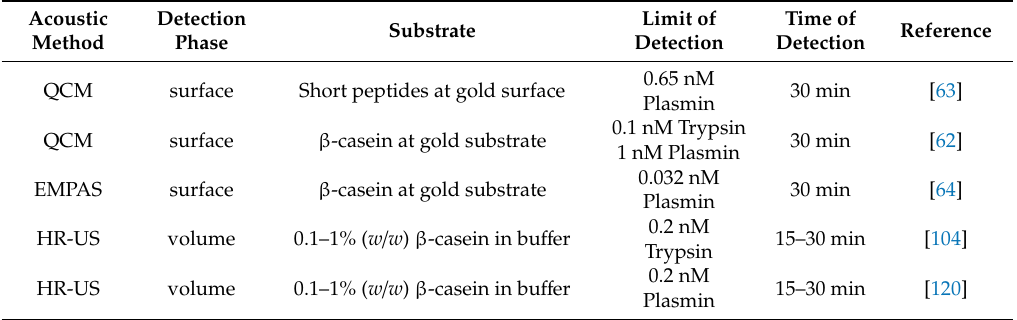
Table 2. Comparison of the sensitivity of acoustics biosensors and high-resolution ultrasonic spectroscopy (HR-US) methods for milk protease detection. QCM: quartz crystal microbalance and EMPAS: electromagnetic piezoelectric